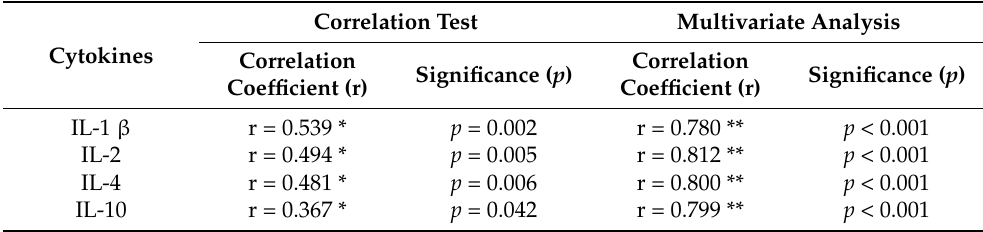
Table 3. Correlation between the plasma level of different cytokines (IL-1 β , IL-2, IL-4 and IL-10) and PACAP-38 with Spearman’s correlation test or with multivariate analysis (taking also into account the type of heart failure: acute or chronic). Statistically significant differences with p -values of ** p < 0.001 and * p < 0.05 are indicated. Correlation Test Multivariate Cytokines